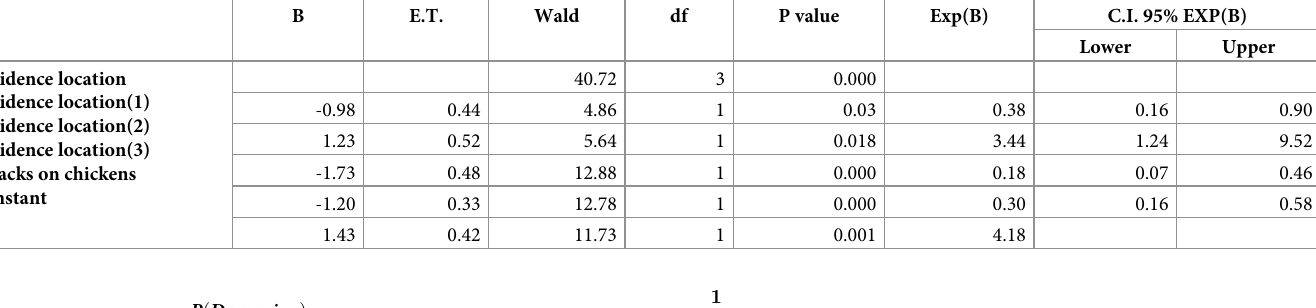
Table 3. Coefficients of the logistic model for evaluating, in the owners of chickens, the characteristics that play a significant role in their perception of Spizaetus isi- dori . Variables included in the first step were residence location, time of residence, whether or not there had been any loss of chickens from attacks by S . isidori , and chicken management. B